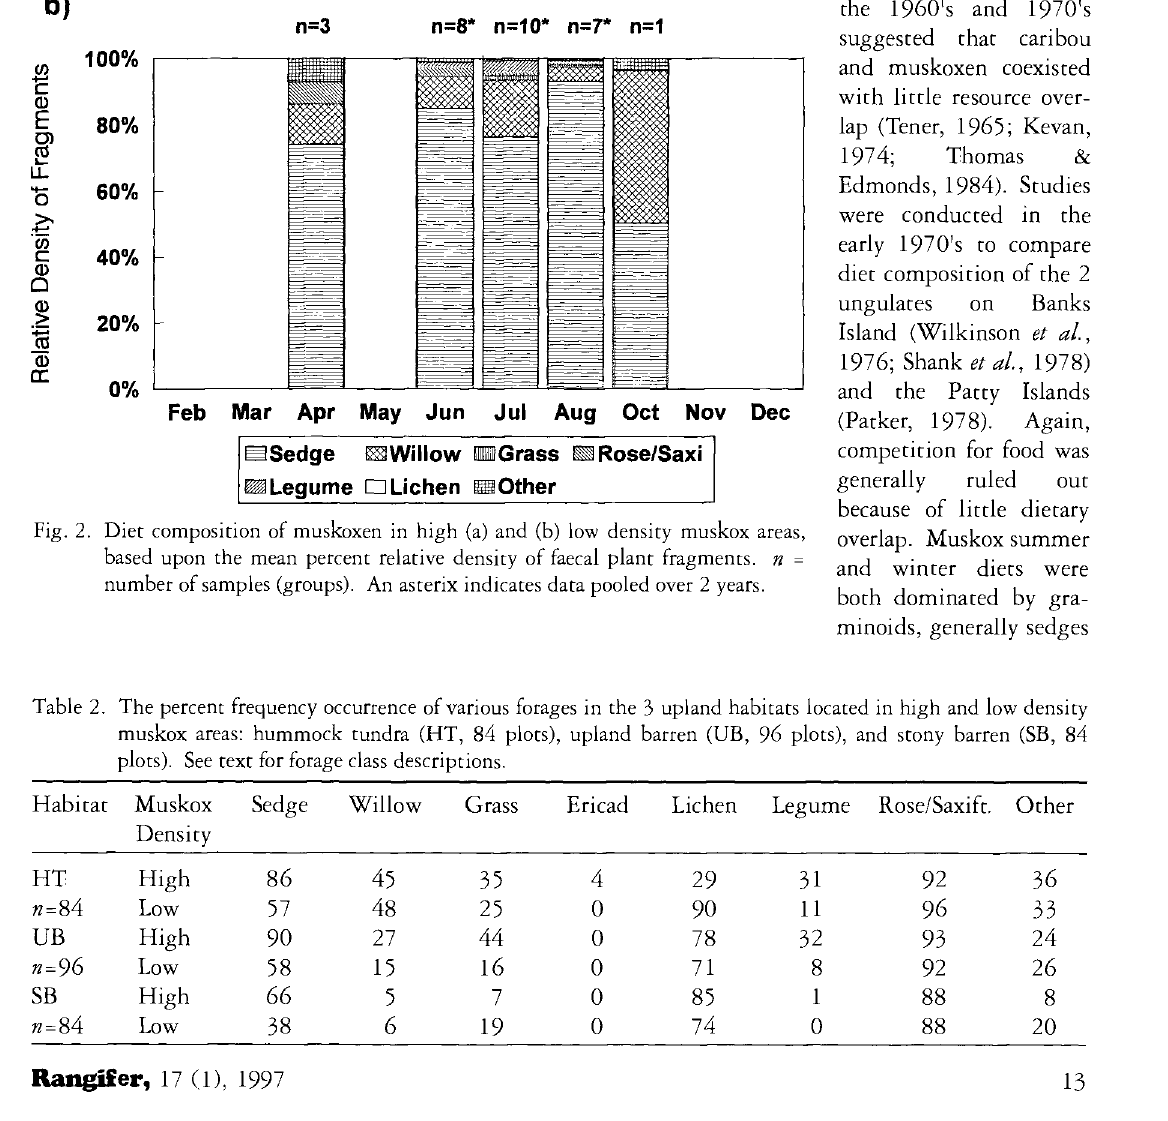
Fig. 2. Diet composition of muskoxen in high (a) and (b) low density muskox areas, based upon the mean percent relative density of faecal plant fragments, n = number of samples (groups). An asterix indicates data pooled over 2 years.